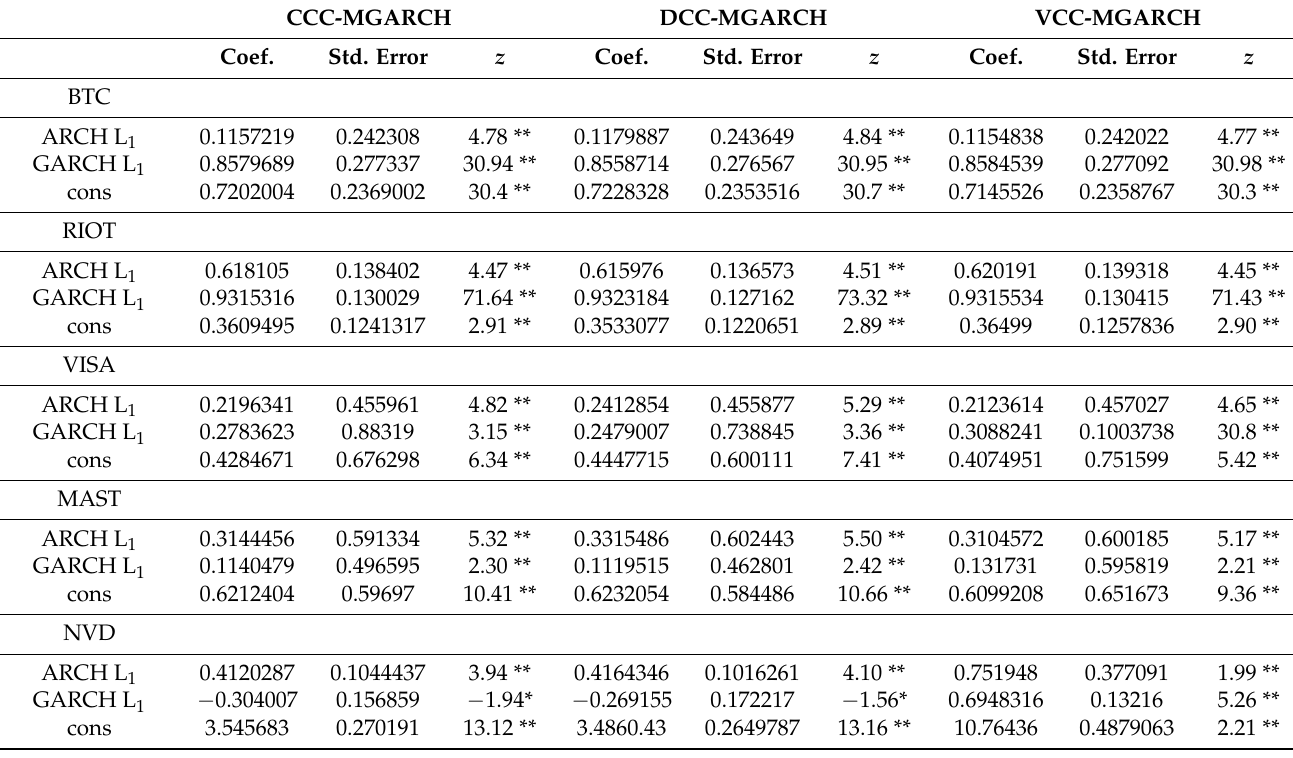
Table 4. Multivariate (M)GARCH